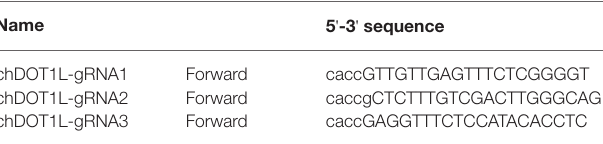
TABLE 1 | Oligonucleotides used for plasmid construction.